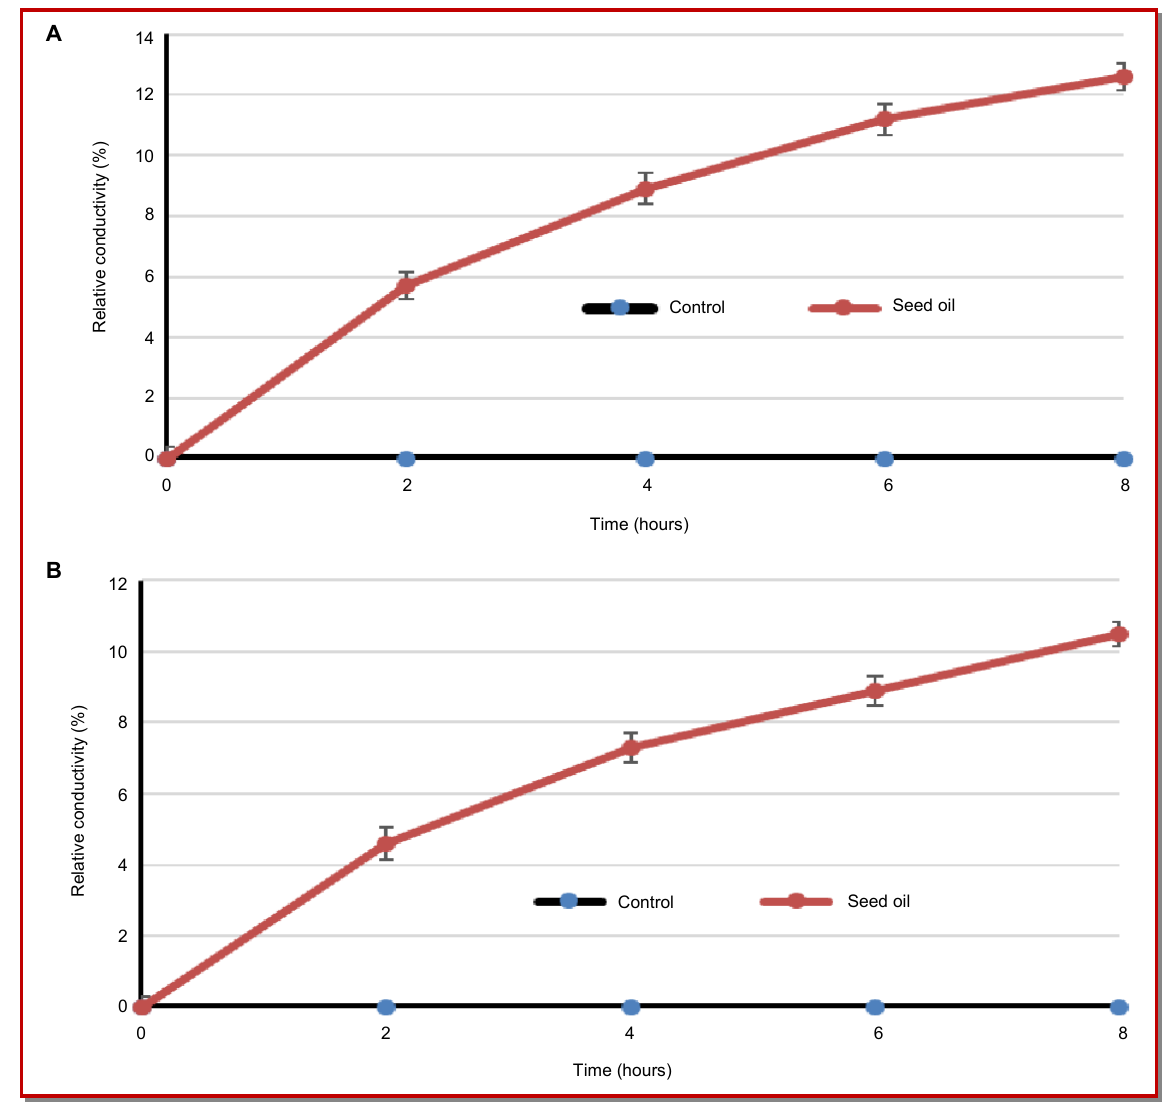
Figure 3: Effect of Caesalpinia bonducella seed oil on membrane permeability of L. monocytogenes NCIM 24563 (A) and E. coli ATCC 25922 (B). Data are expressed as mean ± SD (n =